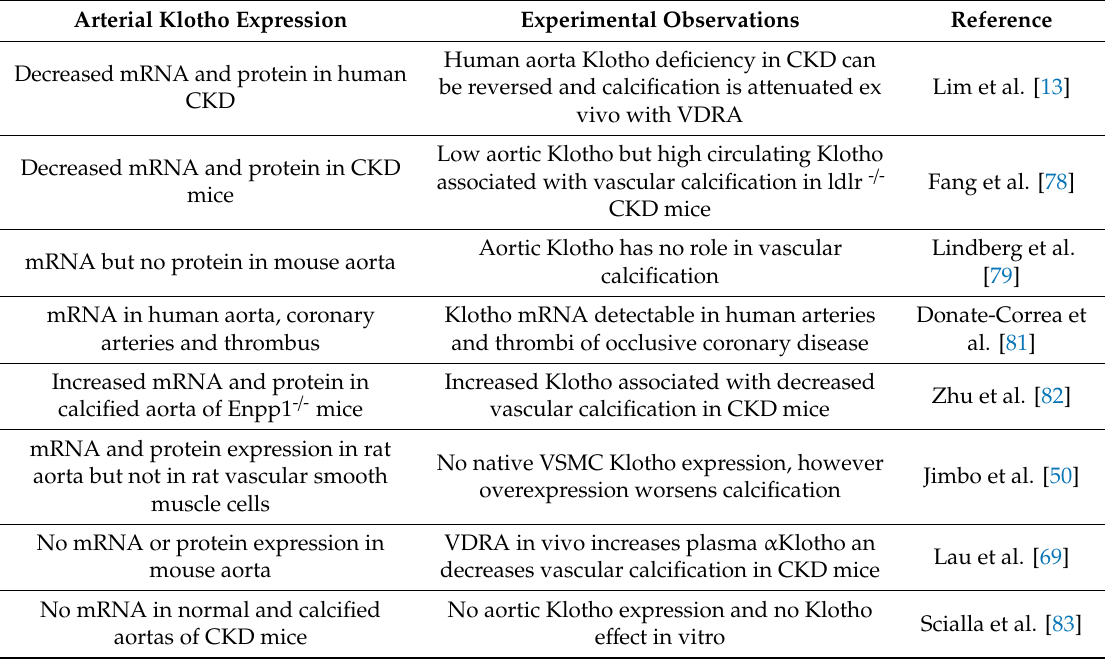
Table 1. Arterial Klotho expression in human and animal aortas. CKD, chronic kidney disease; VDRA, vitamin D receptor